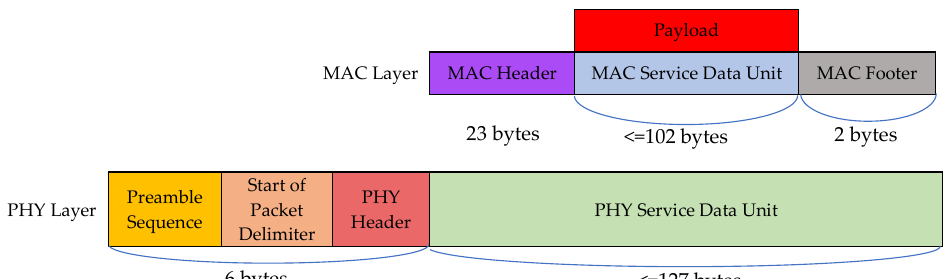
Figure 7. The format of IEEE 802.15.4.